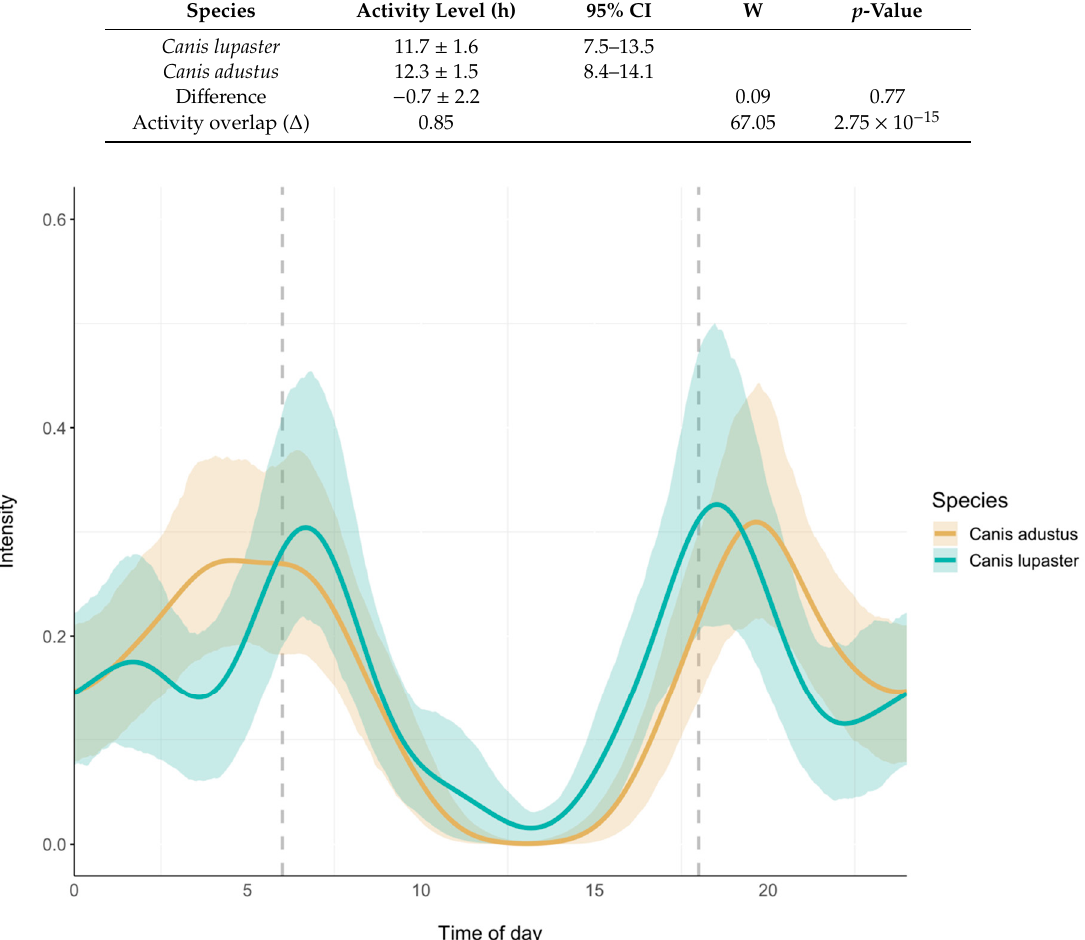
Figure 3. Circadian activity patterns of African wolves (green line) and side-striped jackals (yellow line) based on detection records by camera trapping near artificial waterholes in the Ferlo region (Senegal). Dashed lines represent sunrise (06h00) and sunset (18h00). Shaded areas represent 95% confidence intervals based on bootstrap resampling. Table 1 . Activity level (proportion of time spent at waterholes) and estimated coefficient of activity overlap ( Δ ) between African wolves and side-striped jackals based on detection records by camera trapping near artificial waterholes in the Ferlo region (Senegal). CI: Confidence interval, W: Mardia– Watson–Wheeler test statistic.